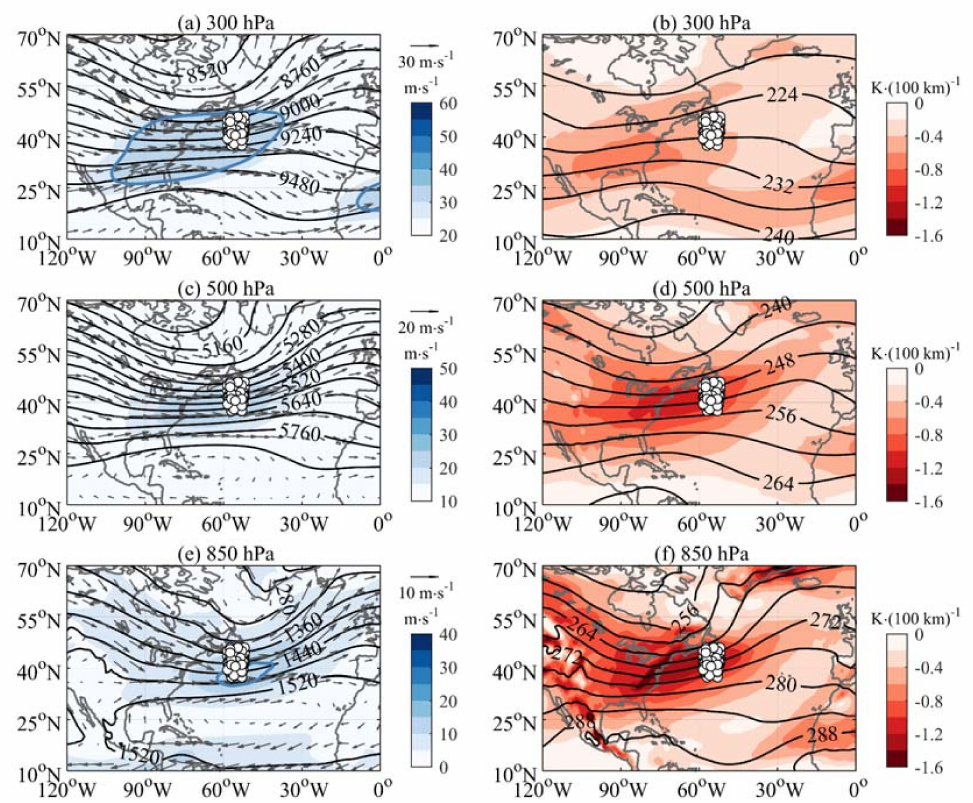
Figure 4. Composite background geopotential height (black contour, contour interval: 120 gpm at 300 hPa, 60 gpm at 500 hPa and 40 gpm at 850 hPa), the wind vectors (dark gray arrows) and the wind speed (blue shading) at the 300 hPa ( a ), 500 hPa ( c ), and 850 hPa ( e ) levels, respectively, and the temperature (the black contours, contour interval: 4 K) and horizontal meridional temperature gradient (red shading, unit: K/100 km) at the 300 hPa ( b ), 500 hPa ( d ), and 850 hPa ( f ) levels, respectively, on the cyclone onset day, based on the cyclones in the Northwest Atlantic. The black circled white balls indicate the center of the cyclone at the sea